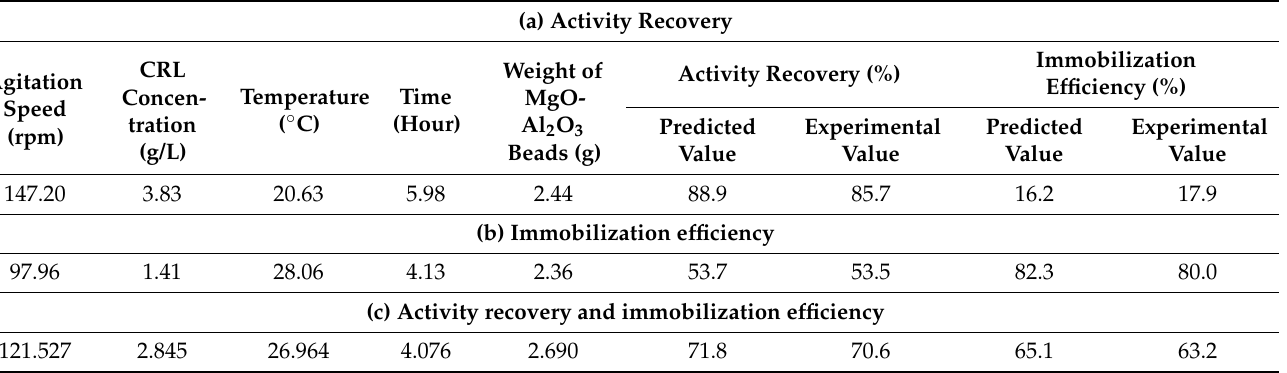
Table 4. Results of model validation at the optimum condition for (a) activity recovery and (b) immo- bilization efficiency (c) activity recovery and immobilization